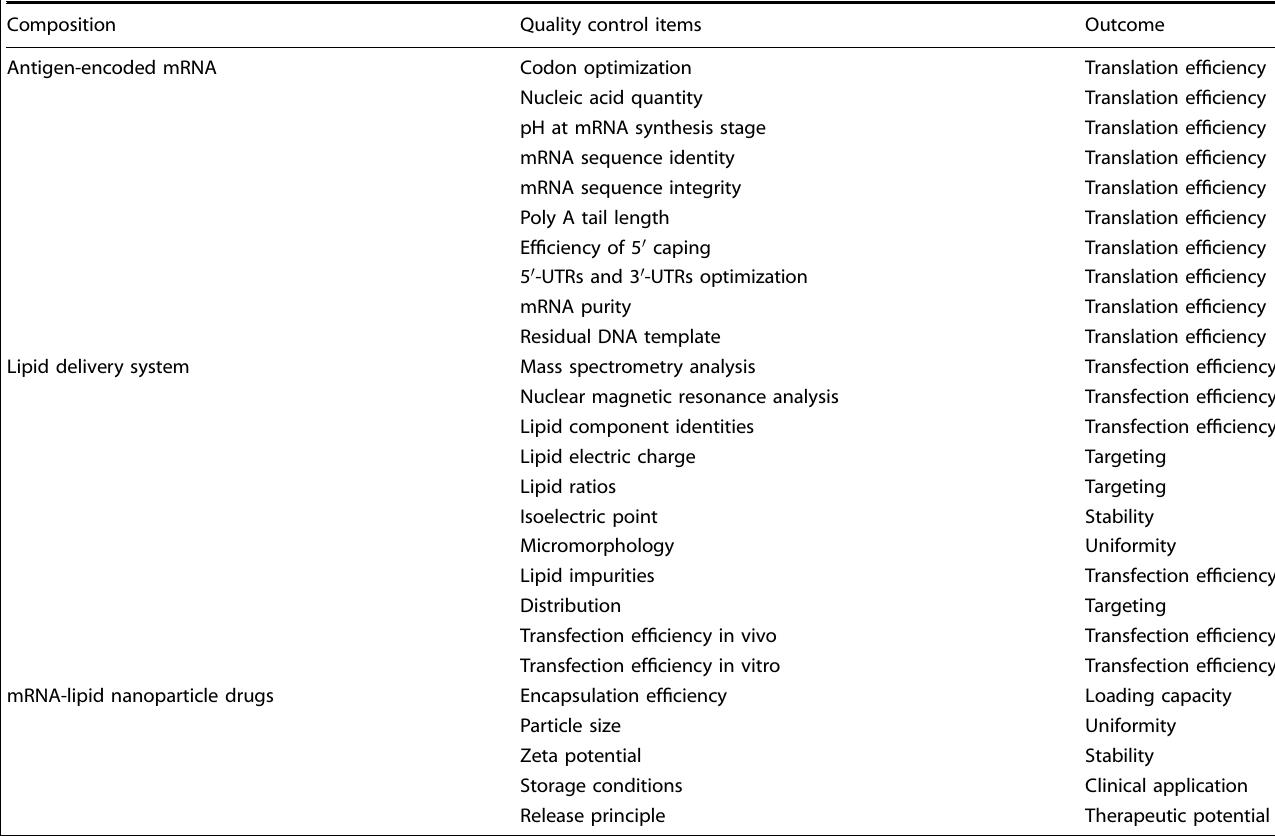
Table 1. Critical quality controls in the preparation of mRNA drugs Composition Quality control